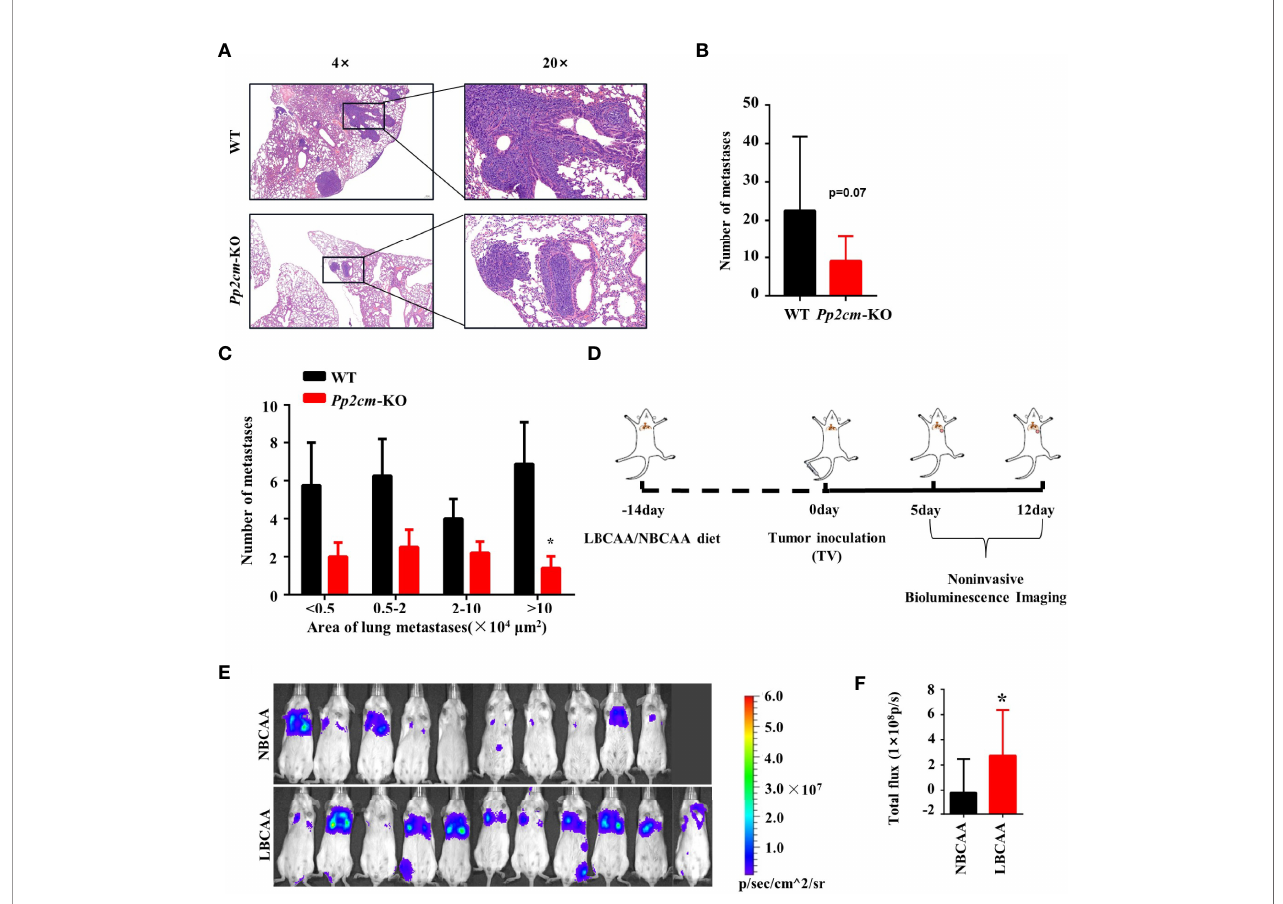
FIGURE 5 | High BCAA inhibits the lung metastasis of breast cancer. (A) Representative images of H&E staining of lung tissues from tumor-bearing Pp2cm -WT/KO mice. (B) Statistical analysis of the total number of lung metastases (WT, n =8; Pp2cm -KO, n =10). (C) Statistical analysis by size of metastases. (D) A lung metastasis mouse model of breast cancer by the tail vein injection in mice fed low BCAA diet (LBCAA) or normal BCAA diet (NBCAA) (E) Detection of lung metastases at 13th day by Bioluminescence Imaging in mice from D (NBCAA, n =10; LBCAA, n =11). (F) Statistics of caudal vein lung metastasis. Mean ± SD, *p < 0.05, Student ’ s